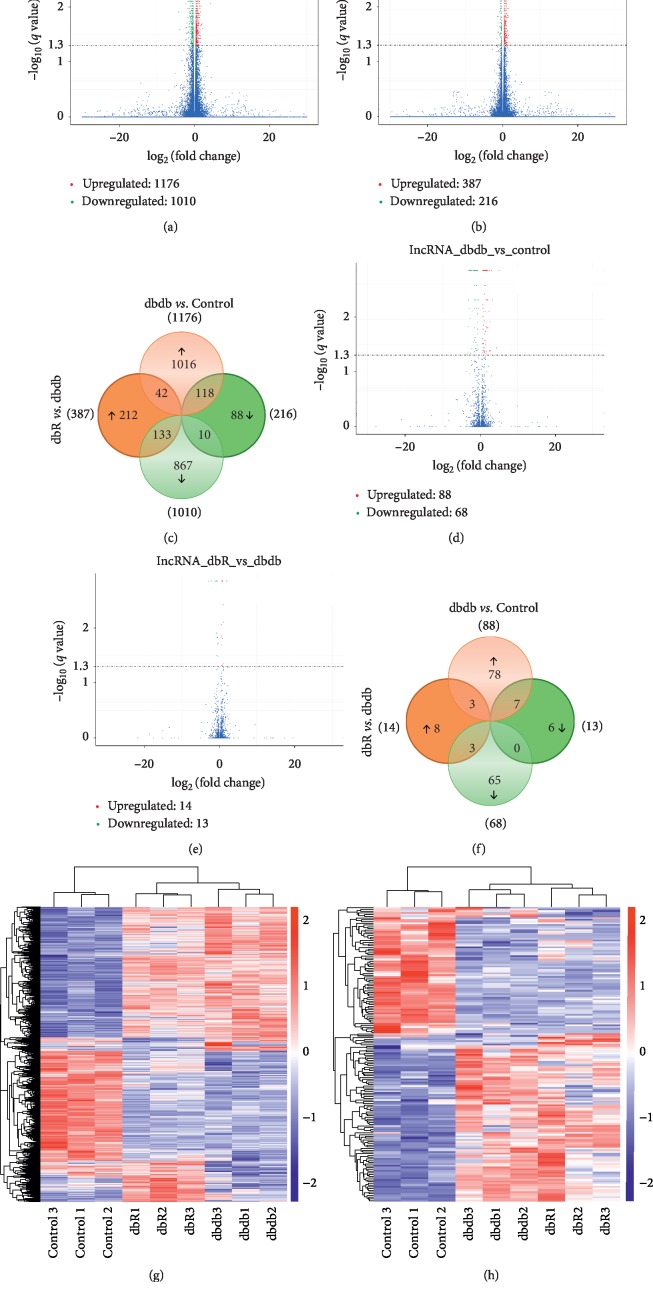
Differentially expressed mRNAs and lncRNAs in the renal cortices of diabetic nephropathic mice. Volcano plot for comparison of (a) mRNA expression between the dbdb and control group, (b) mRNA expression between the dbR and dbdb group, (d) lncRNA expression between the dbdb and control group, and (e) lncRNA expression between the dbR and dbdb group. On the right side, the red color is indicative of the upregulated genes (q < 0.05); on the left side, the green color is indicative of the downregulated gene (q < 0.05). The blue points indicate mRNAs that were not statistically significant (q > 0.05). Venn diagrams illustrate the number of significantly differentially expressed (c) mRNAs and (f) lncRNAs. The overlapping areas represent the coregulated genes in both dbdb/control and dbR/dbdb analyses. Differentially expressed (g) mRNAs and (h) lncRNAs (q < 0.05) in dbdb/control or dbR/dbdb analyses were assessed using hierarchical clustering. Each row represents a single gene expression, and each column represents one tissue sample.